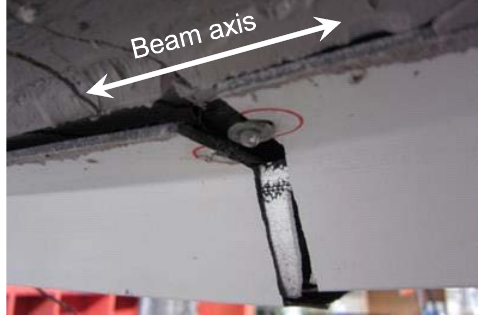
Figure 10. Fracture of AGC beam around